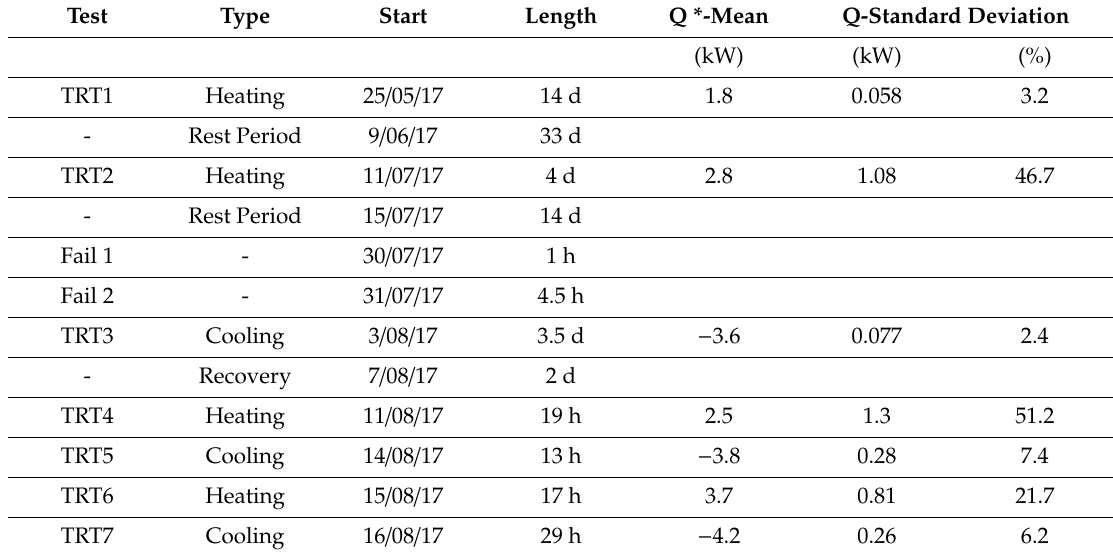
Table 2. TRTs performed and principal rest periods.